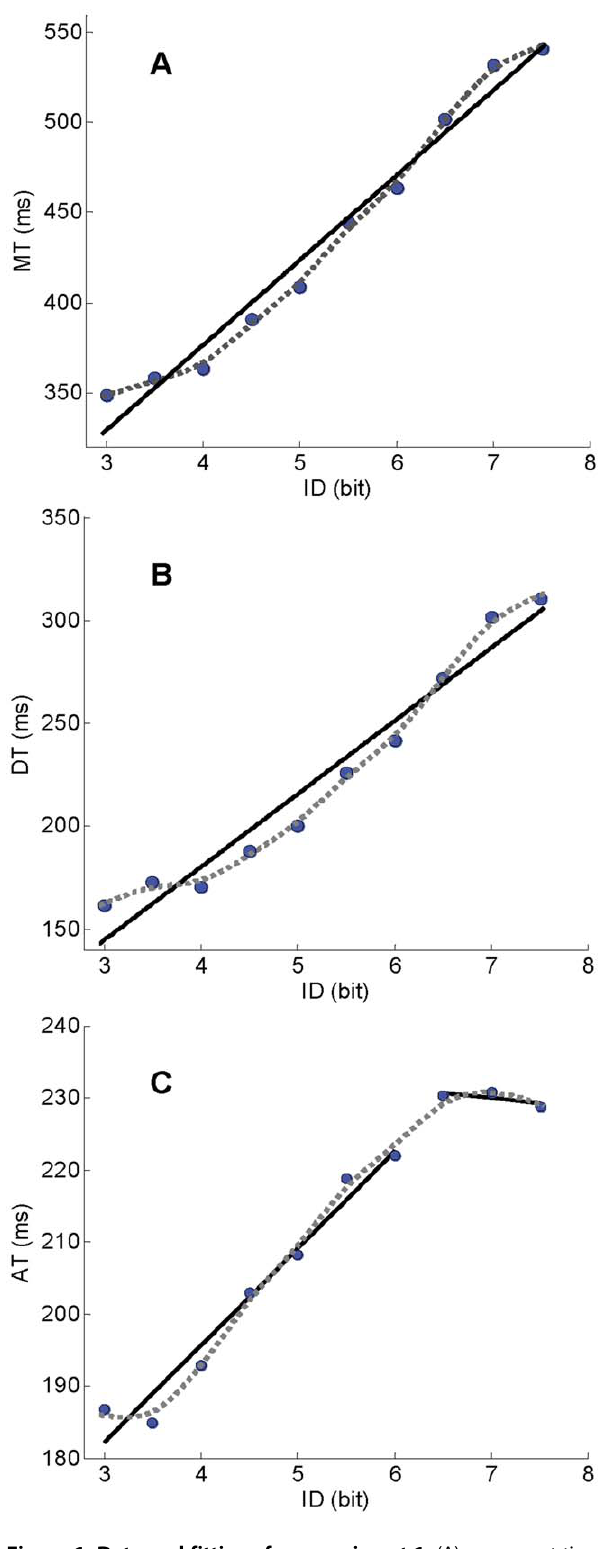
Figure 1. Data and fittings for experiment 1. (A) movement time; (B) deceleration time; and (C) acceleration time. Each dot represents mean value across participants for the corresponding ID condition. Dashed grey lines represent spline fitting curves. Black lines represent linear regressions.